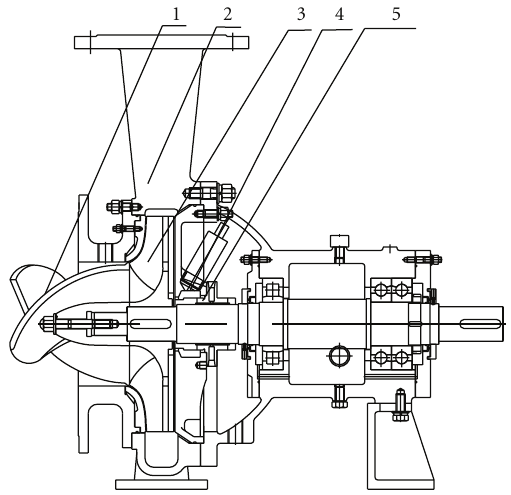
Figure 1: MC pulp pump. (1) Turbulence generator. (2) Casing. (3) Impeller. (4) Gas outlet. (5) Mechanical seal.